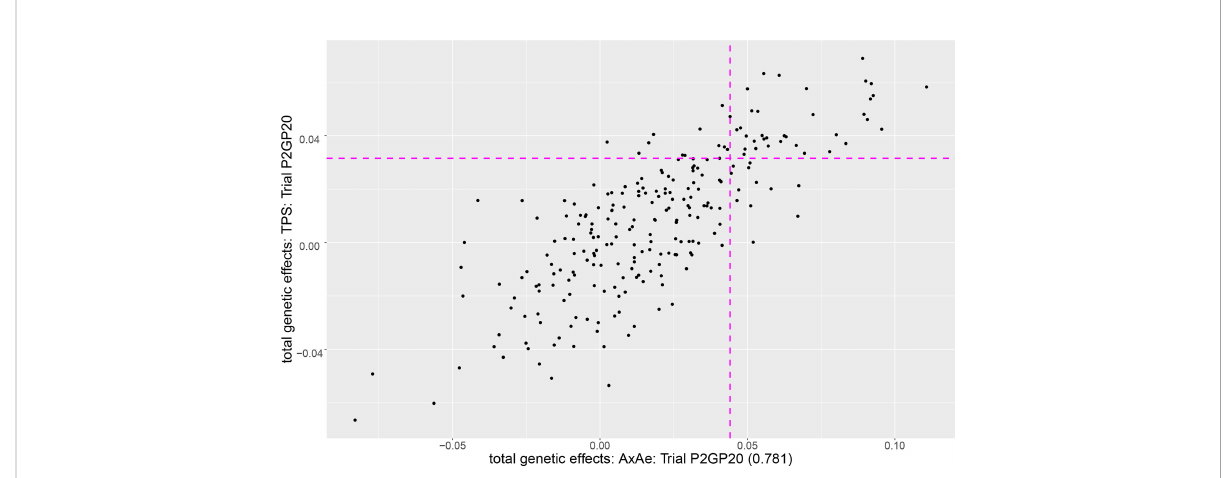
by that model. The plots are for the additive effects (top plot) and total effects (bottom plot). For each model, the distribution excludes the set of trials for which that model was the best fi tting model. Supplementary Table 2 contains the matching six- point summary for each model and type of effect. We have chosen to consider median percentage mis- classi fi cation. This is to avoid the in fl uence of a small number of trials for which there are large differences in the additive and/ or non-additive variance parameter estimates, and consequently in fl ated values of mean percentage mis-classi fi cation between the best and other model. The results for median percentage mis-classi fi cation are consistent with those of Table 3 for correlation between the predicted genetic effects. The A×Ae model has the lowest rate of mis-classi fi cation (4.08% for additive, 4.17% for total). The TPS model has a higher rate of mis-classi fi cation than both AR models (10.42% and 11.52% for TPS compared to 6.52% and 8.33% for A×A, and 4.08% and